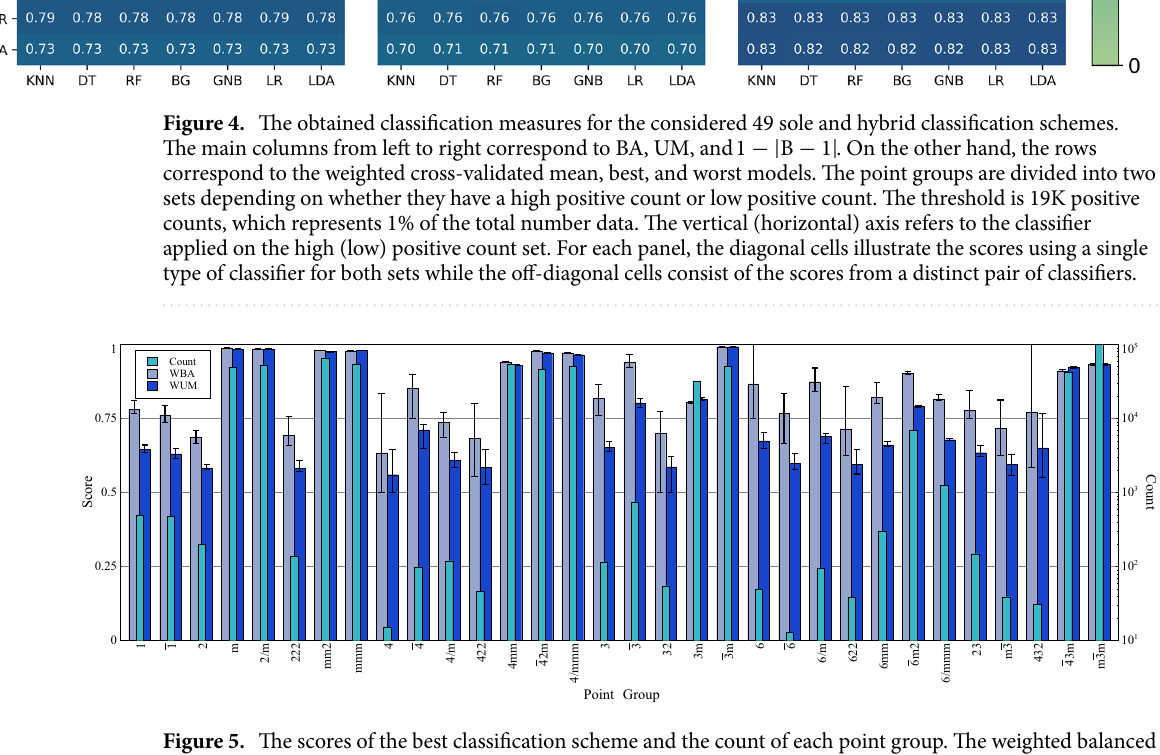
Figure 5. The scores of the best classification scheme and the count of each point group. The weighted balanced accuracy and the unit normalized MCC of the best performance are observed with using a pair of classifiers. RF is used for the high positive count while KNN is used for the low positive count. In the case of high positive count, the scores are very close to each other and above 90% except for point group 3 m . On the other hand, scores span between 50% and slightly above 85% for the low positive count. Moreover, the weighted balanced accuracies surpass the weighted unit normalized MCC by approximately